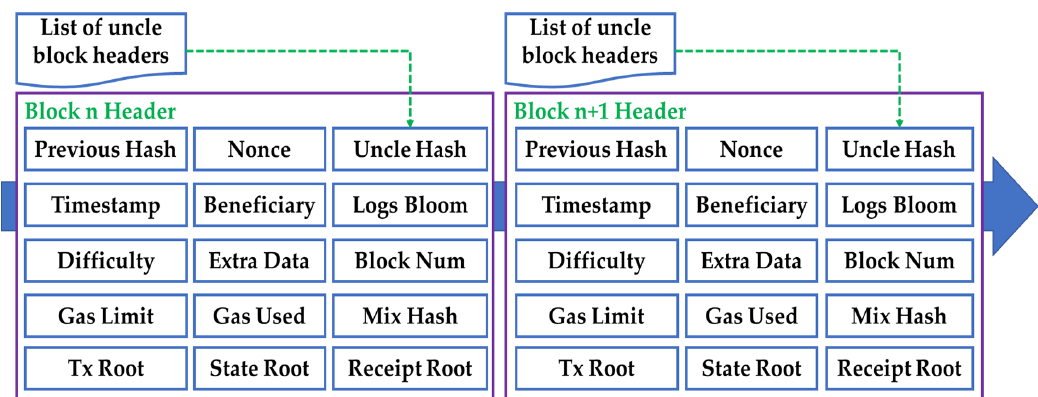
Figure 6. Example of block data structure for the Ethereum blockchain .